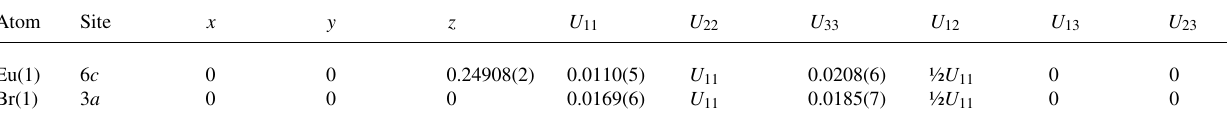
Table 5. Atomic coordinates and displacement parameters (in Å 2 ) for the composition Eu 2 [BN 2 ] 1 − x Br 1+ x with x = 0.05(2). Atom